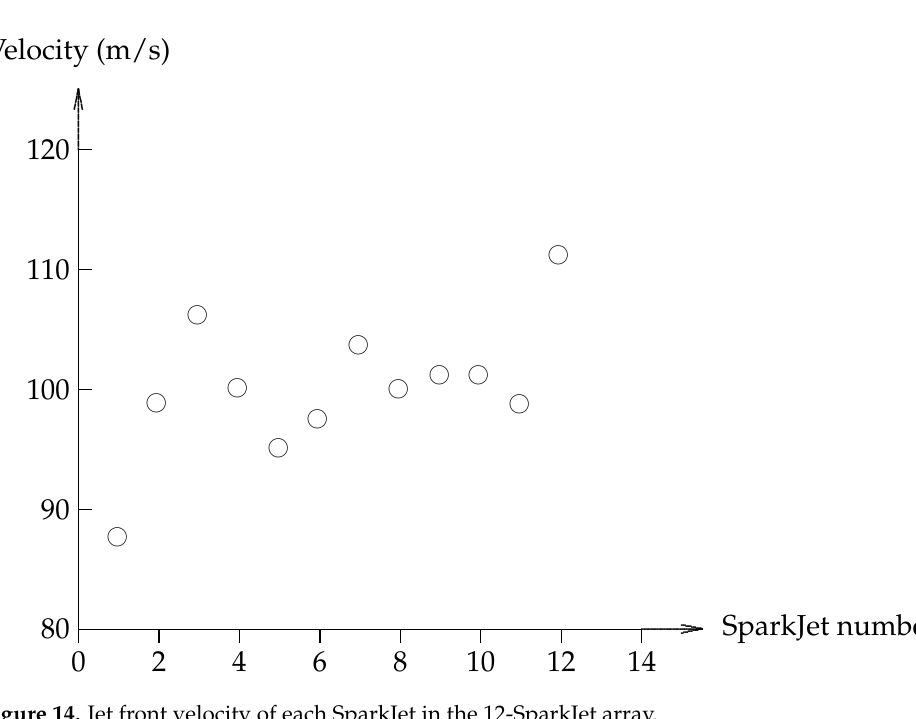
Figure 15. Schlieren images of 12-SparkJet array and single SparkJet. Adapted from [54].